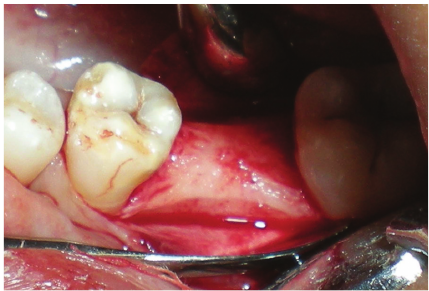
Figure 4: Broad buccolingual width of the residual